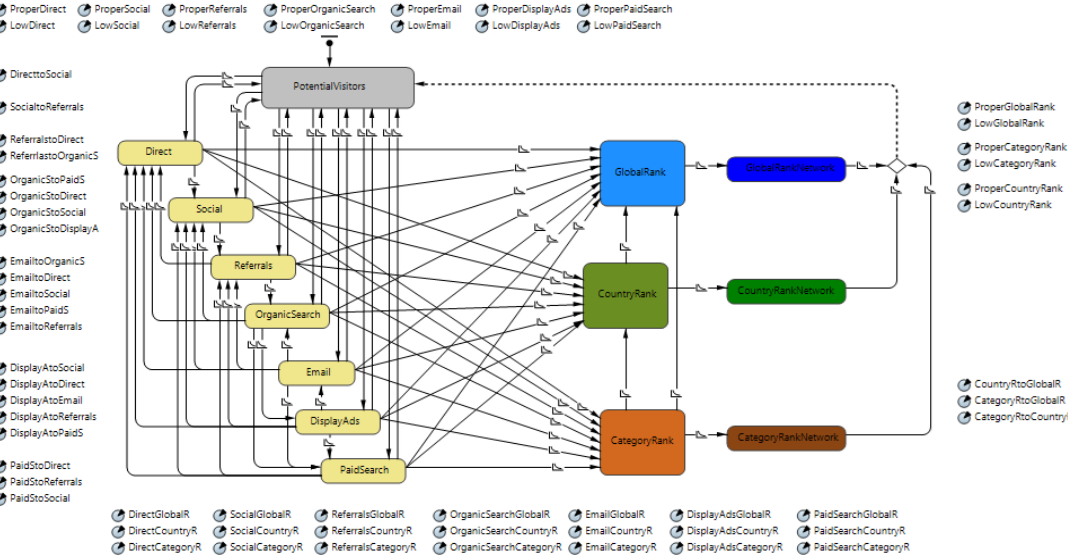
Figure 2. Agent-based modeling (ABM), where the influence of the Social, Direct, Referrals, Email, Display Ads, Organic Search and Paid Search metrics on the Global Rank Network, Country Rank Network and Category Rank metrics is examined.